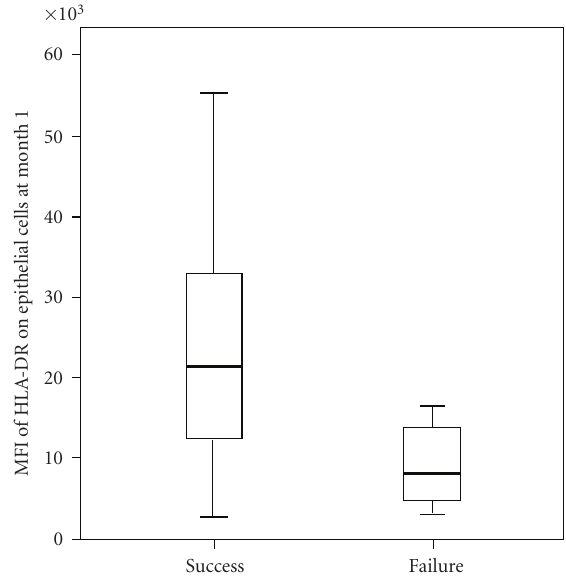
Figure 2: The expression of HLA-DR on conjunctival epithelial cells (MFI-mean fluorescence intensity) collected by impression cytology 3 months after surgery in eyes with surgical success and failure at 6 months of follow-up ( P = . 082). Open circles and asterisk indicate the outliers.